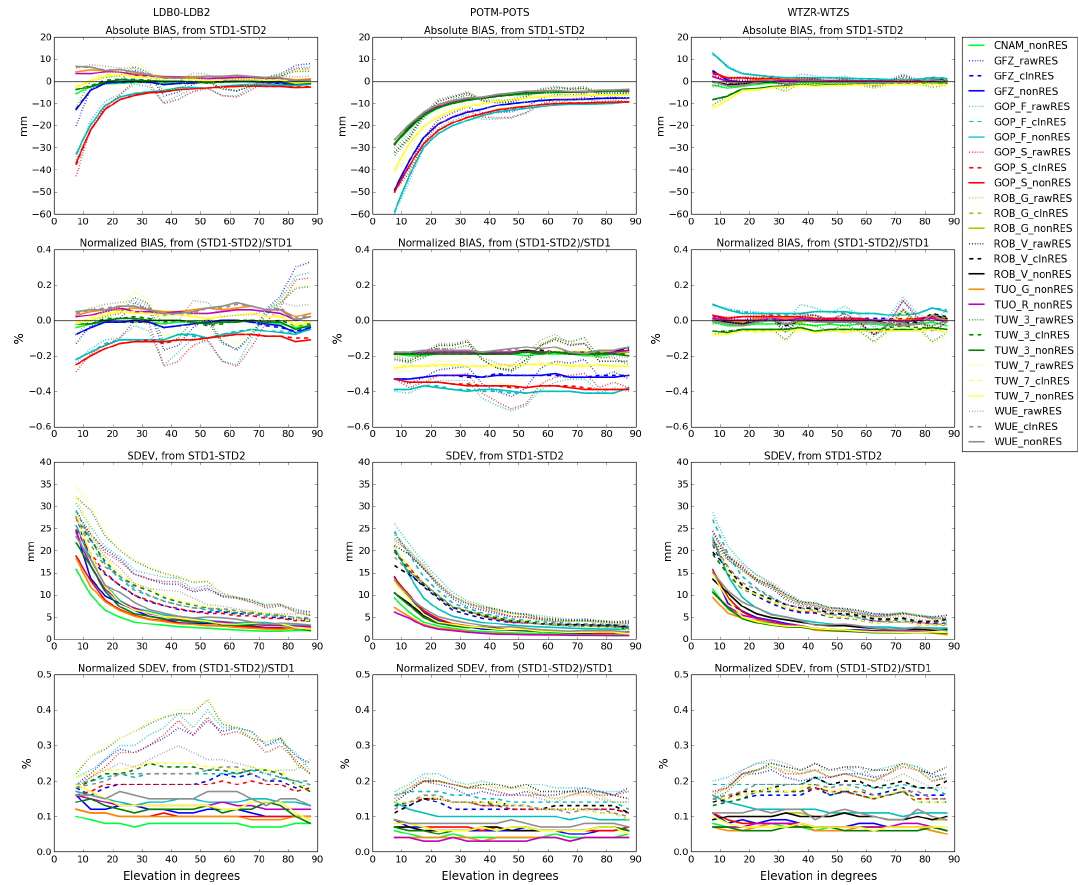
Figure 14. Comparison of GNSS STDs at dual stations computed over whole benchmark period from individual GNSS solutions in the slant direction for dual stations from left to right: LDB0-LDB2, POTM-POTS and WTZR-WTZS. Statistical parameters from top to bottom: bias, normalized bias, standard deviation and normalized standard